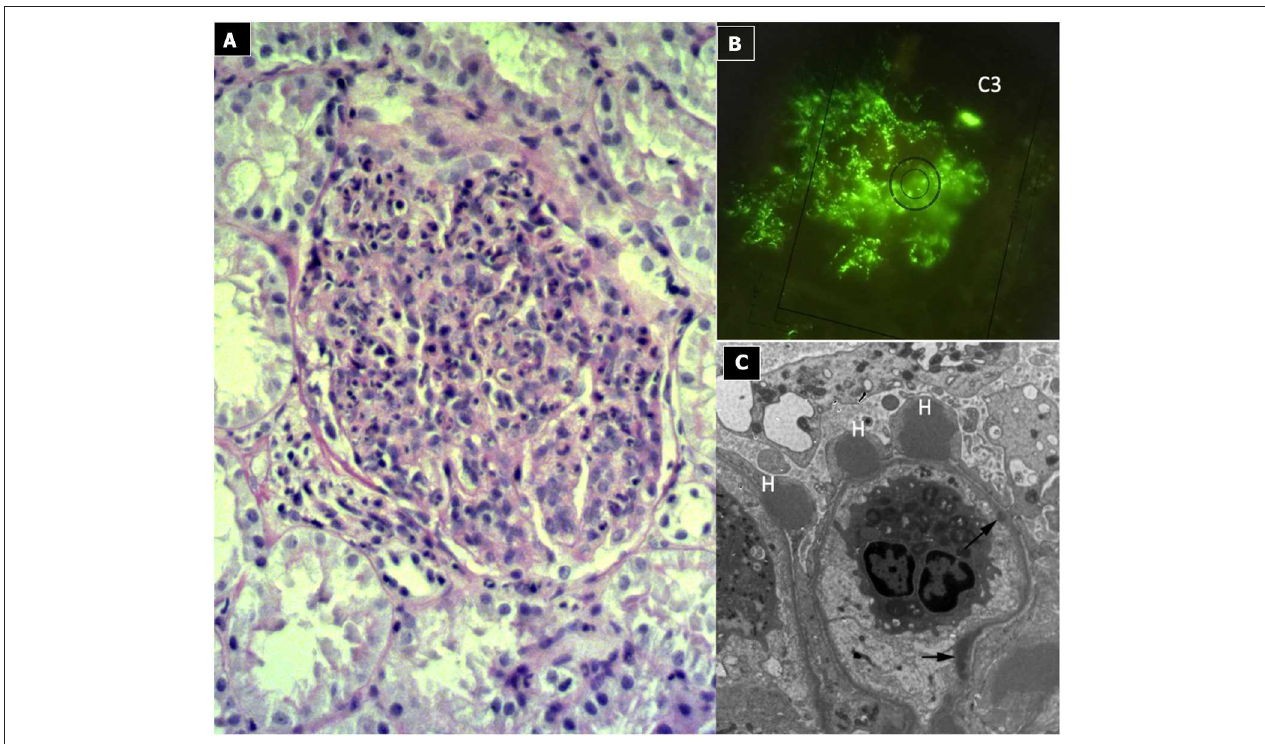
FIGURE 2 | Post-infectious glomerulonephritis. (A) LM (PAS stain) shows endothelium-mesangial proliferative GN, with global increase of mesangial cellularity and matrix deposition. (B) IF: Starry sky distribution of C3. (C) EM: typical subepithelial deposits